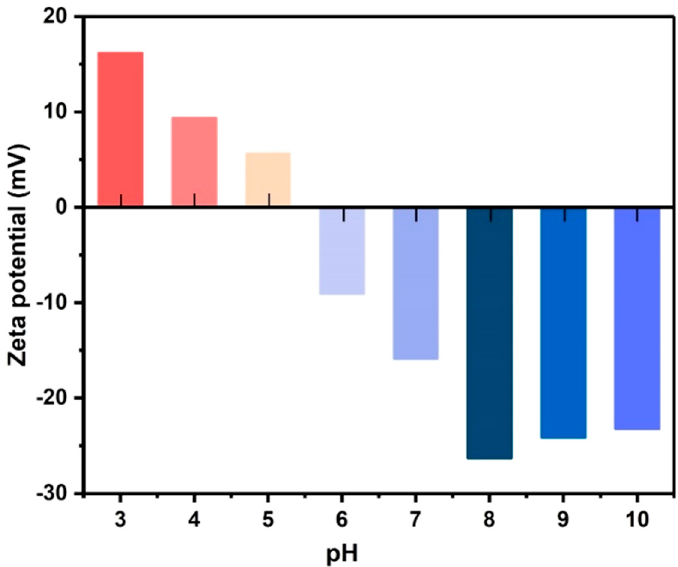
Figure 1. Zeta potential of h-BN particles as a function of pH for pure ethanol suspension.